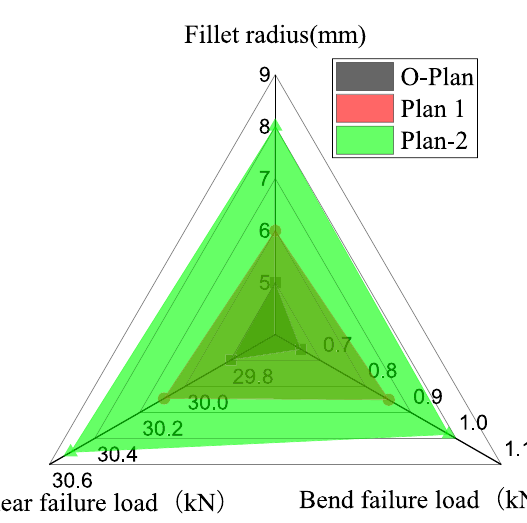
Figure 14. Finite element calculation results of the fillet radius